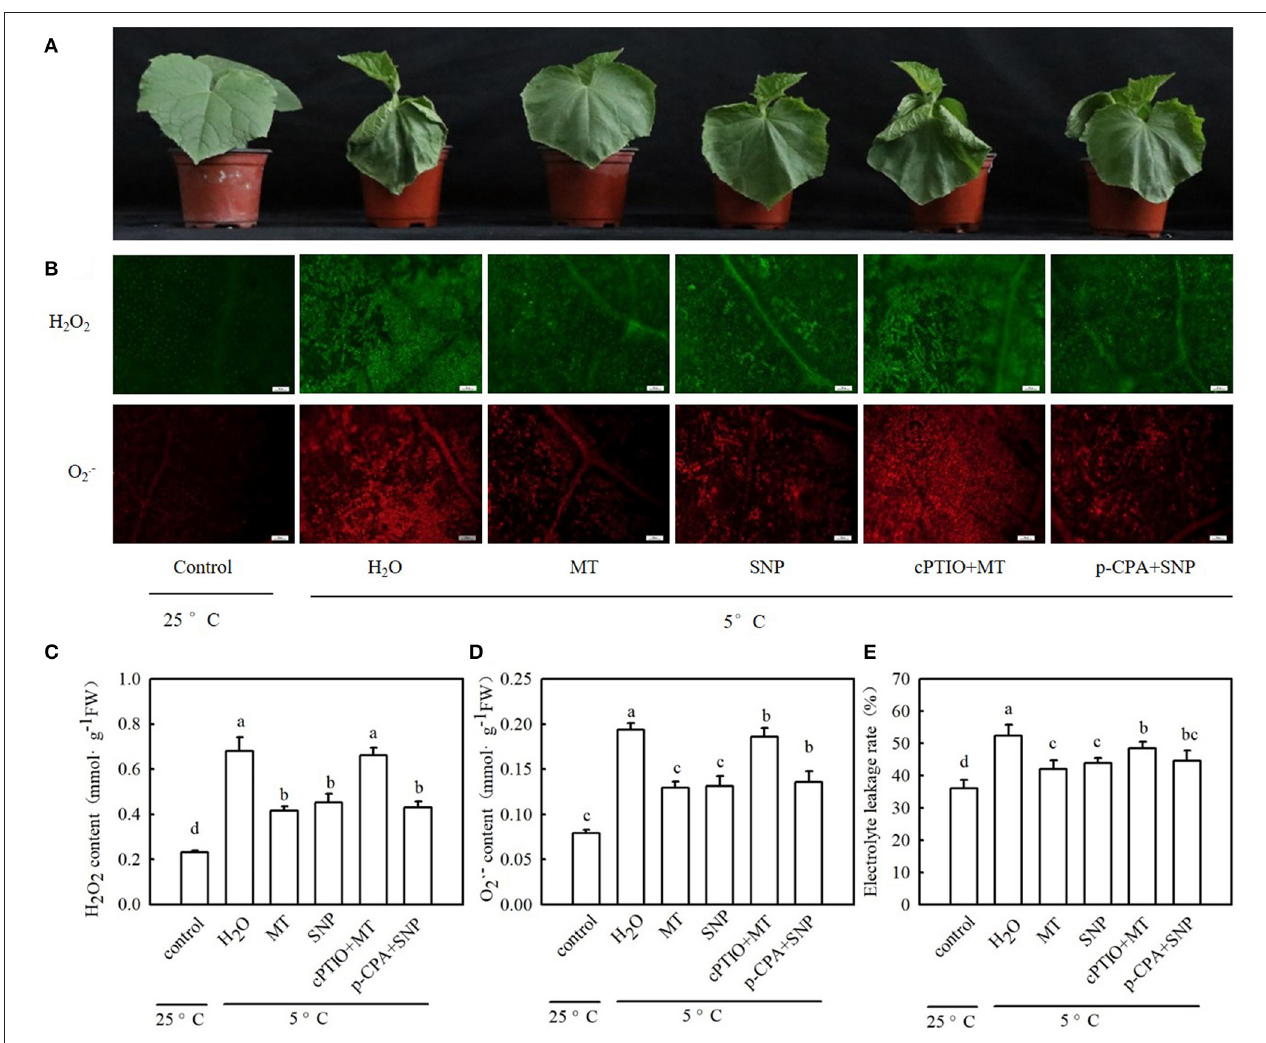
FIGURE 8 | Interactive effects of MT and SNP on the reactive oxygen species (ROS) accumulation and EL in cucumber seedlings under cold stress. (A) Seedling phenotype; (B) Inverted microscope imaging of H 2 O 2 and O 2 − ; (C) H 2 O 2 content; (D) O 2 − content; and (E) EL. Three-leaf stage seedlings were foliar sprayed with 100 µ M MT, 75 µ M SNP, 100 µ M cPTIO + 100 µ M MT, 50 µ M p-chlorophenylalanine (p-CPA) + 75 µ M SNP, or deionized water (control) for 24h and then were exposed to 5 ◦ C for 48h. Data are represented as mean ± SD ( n = 3). Different letters indicate a significant difference between samples according to Duncan’s new multiple range test ( p <